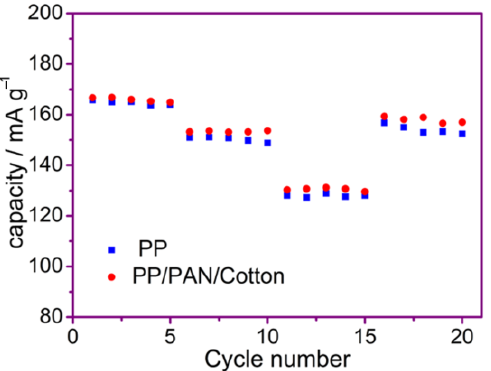
Figure 11. Rate capability of the batteries with PP membrane and fiber membrane.